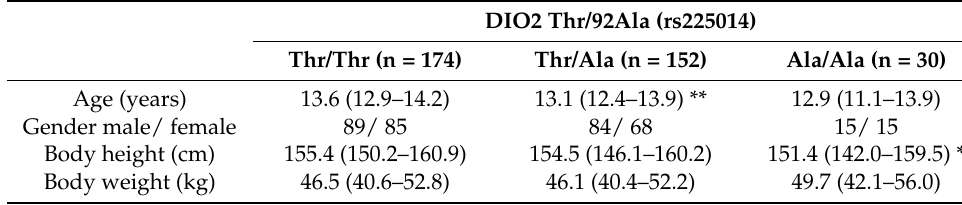
Table 4. Clinical characteristics of the DIO2 Thr92Ala (rs225014) SNP